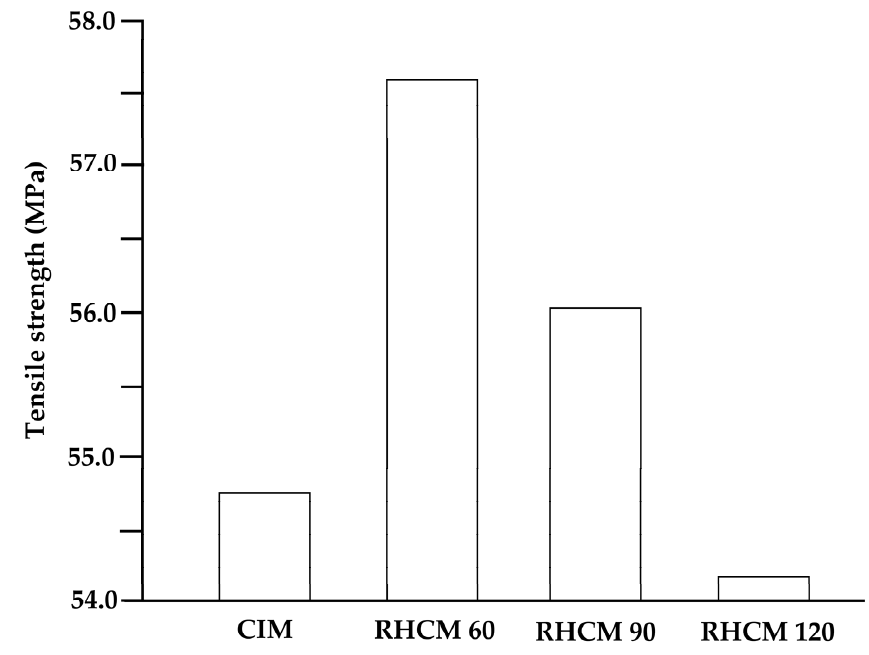
Figure 17. Tensile strength of RHCM and CIM samples.